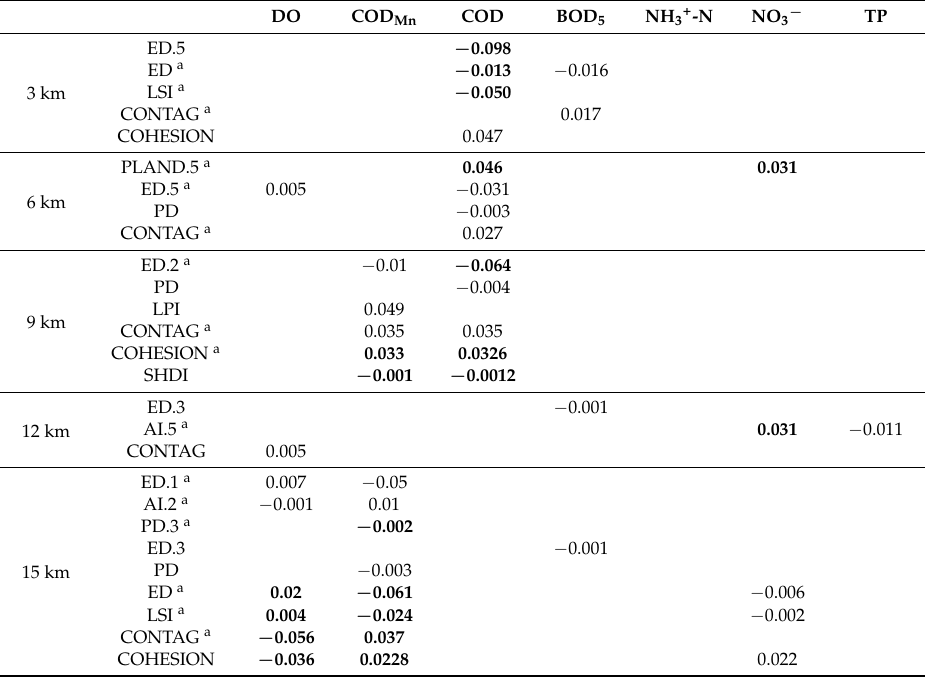
Table 3. Summary of the partial least squares regression (PLSR) models for specific water contaminants during the dry season. DO